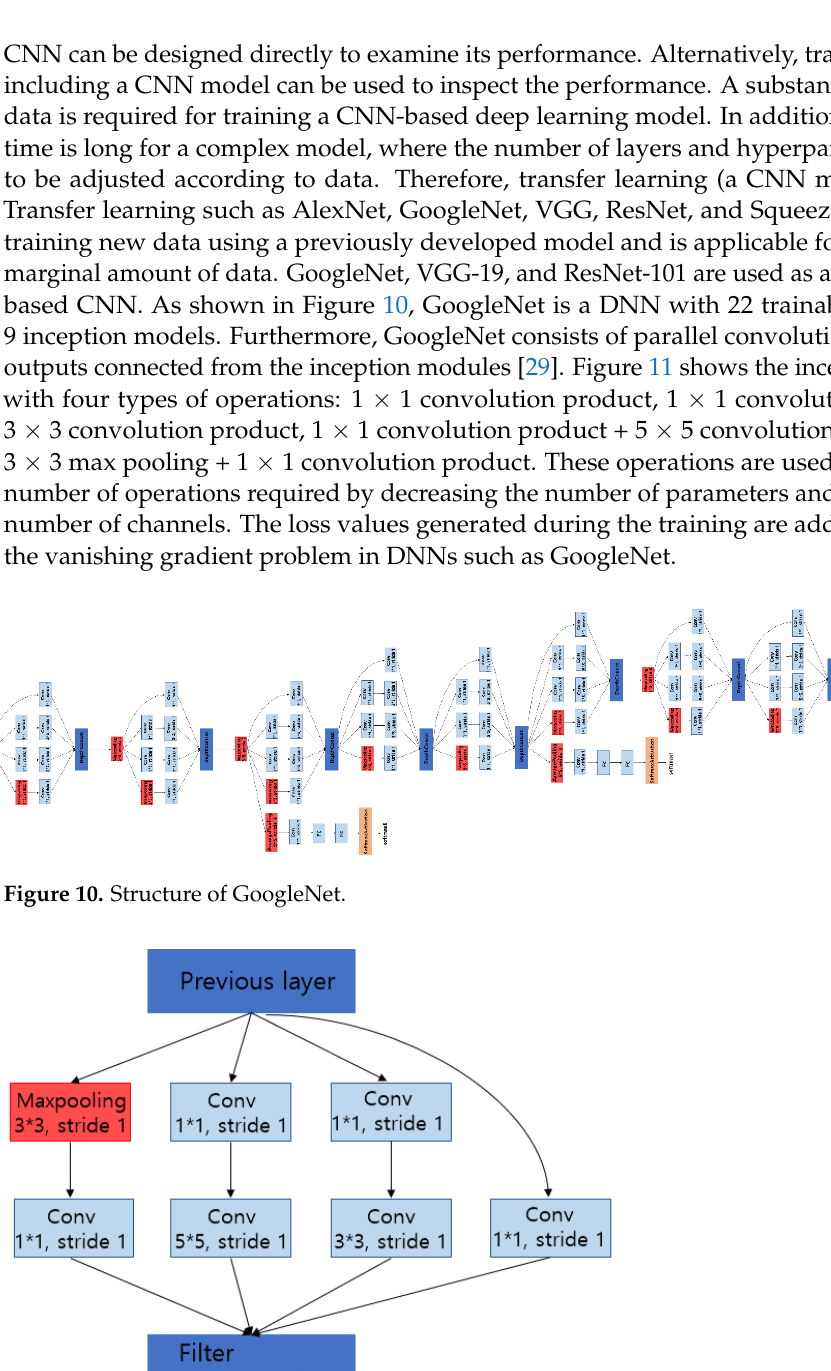
Figure 9. Time – frequency representation by WSST.